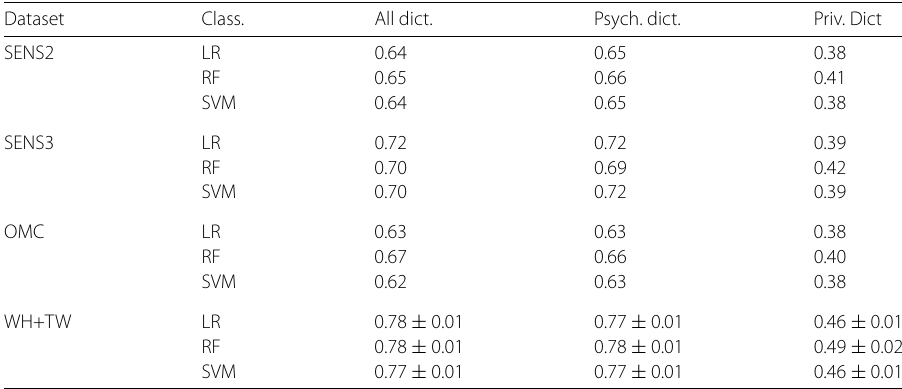
Table 11 Classification results (macro averaged F1-score) using dictionary features. Results on WH+TW are averaged on ten samples Dataset Class. All dict. Psych. dict. Priv. Dict SENS2 LR 0.64